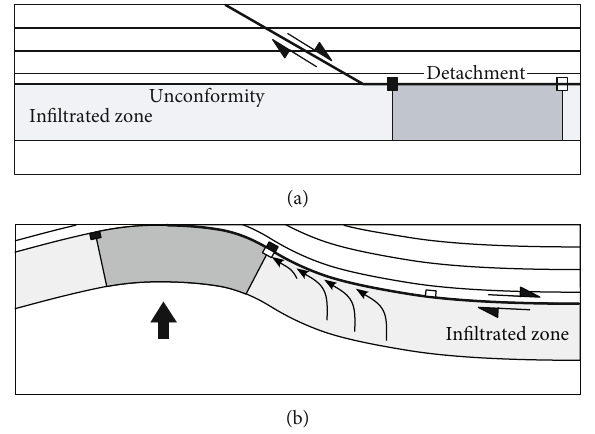
Figure 5: (a) Initial geometry of a buried unconformity with an in fi ltration zone in which the pores are fi lled by surface water (grey zone). A normal fault with detachment nucleates on this unconformity. (b) A core complex has formed. All rocks in the dark grey area have passed below the black split marker. During extension and exhumation, this volume would have released fl uid, which would have been focused into the detachment